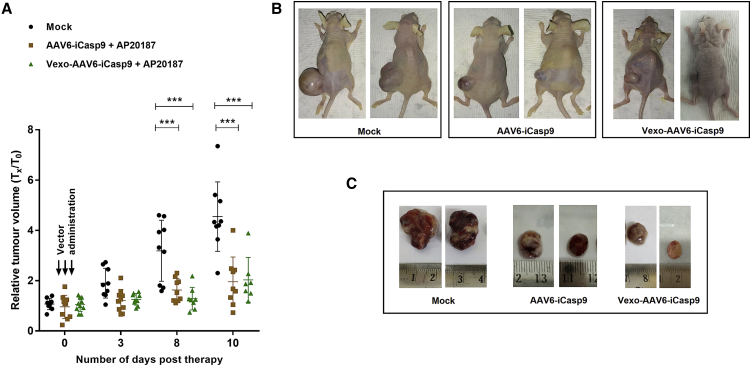
Vexo-AAV6-iCasp9 Vectors Inhibit Tumor Growth in a Huh7 Cell Xenograft Model(A) HCC tumor-bearing mice were injected with PBS (Mock) intratumorally or with AAV6-iCasp9 or Vexo-associated AAV6-iCasp9 vectors (2 × 1010 vgs/animal). Animals from both the AAV6-iCasp9 and Vexo-AAV6-iCasp9 group demonstrated significant tumor regression when compared to mock-injected animals (data are mean ± SD, n = 7–10 per group, ∗∗∗p < 0.001). (B and C) Representative images of animals (B) and their tumors after enucleation (C).